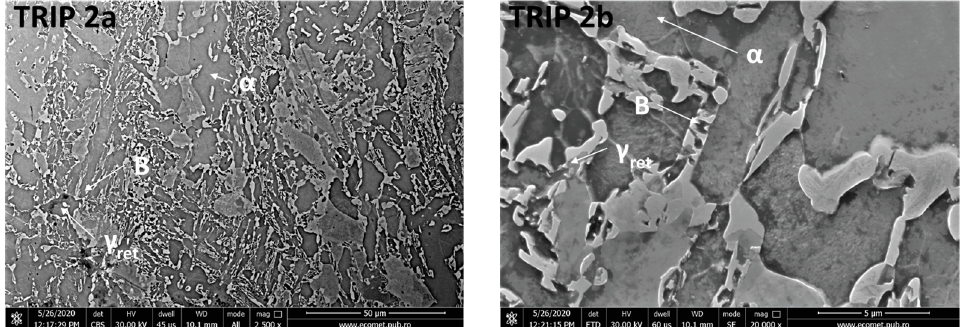
Figure 2. Microstructures (BSE—( a ); SE—( b )) of TRIP 2 steel after heat treatment.